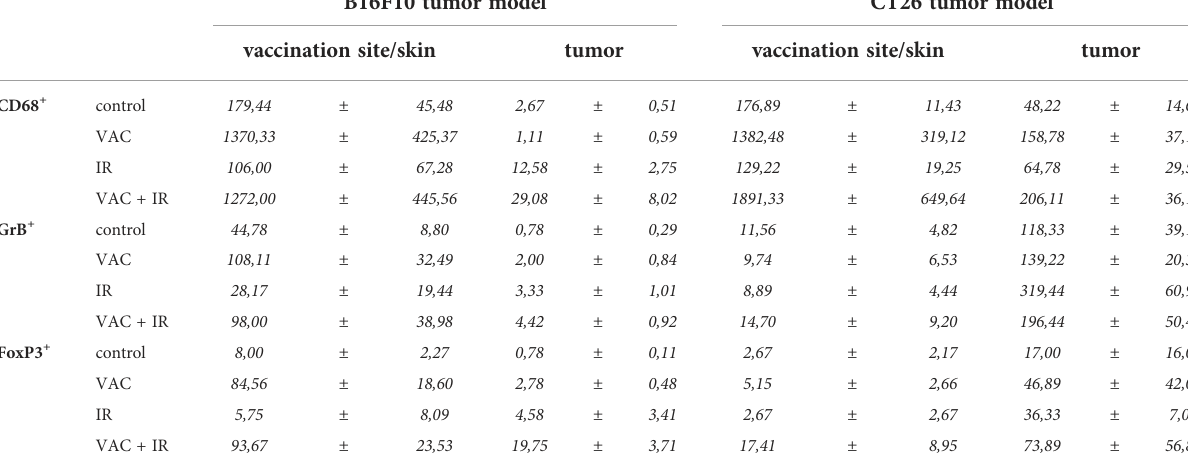
TABLE 1 The amount of immune cells at the vaccination site and in tumor in both tumor models.